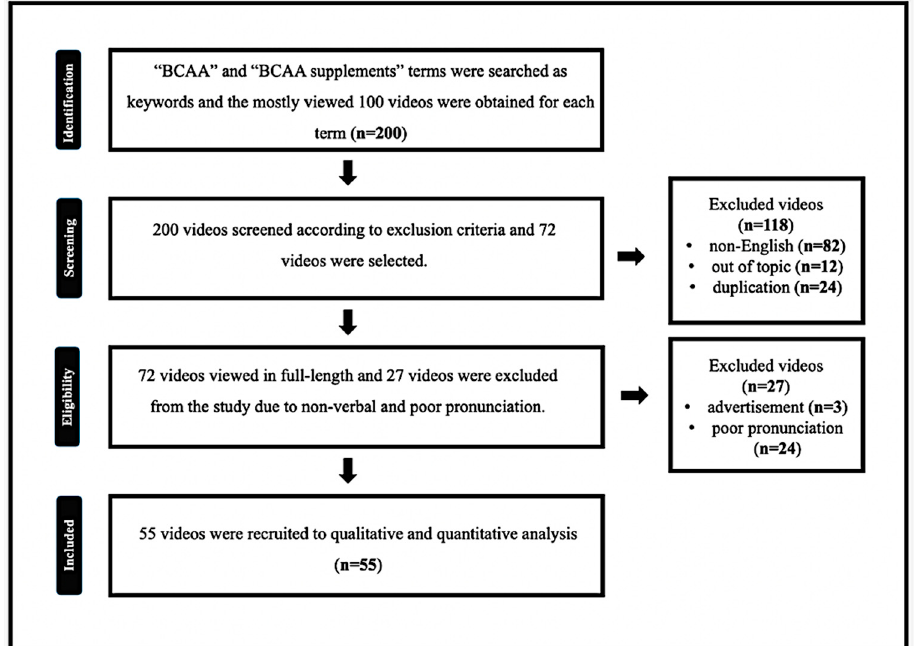
Figure 1. Flow chart of video selection procedure according to eligibility criteria.